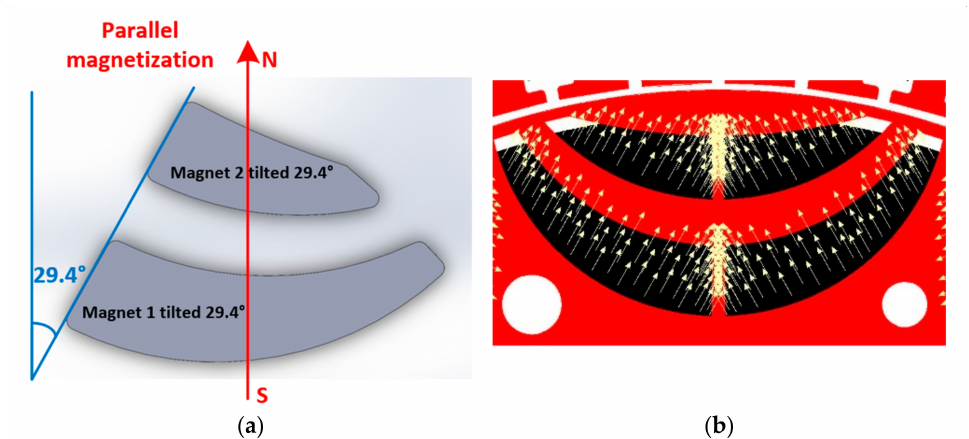
Figure 9. Tilting the magnet part within parallel magnetization to obtain the titled magnetization pattern. ( a ) Illustration how the real magnet part should be tilted within parallel magnetization; ( b ) View of the desired magnetization pattern in the motor model if magnetized as in ( a ).